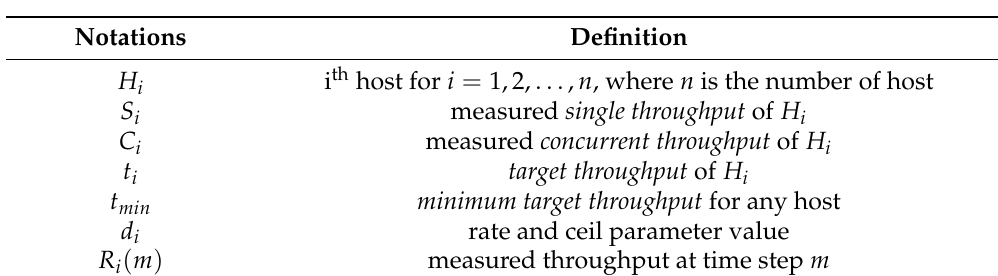
Table 2. Definition of